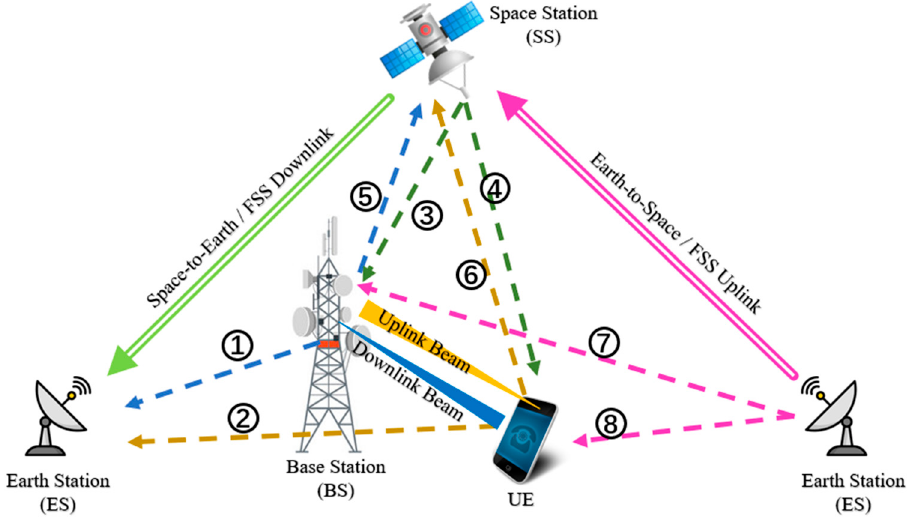
Figure 2. Coexistence of the FSS and cellular systems.